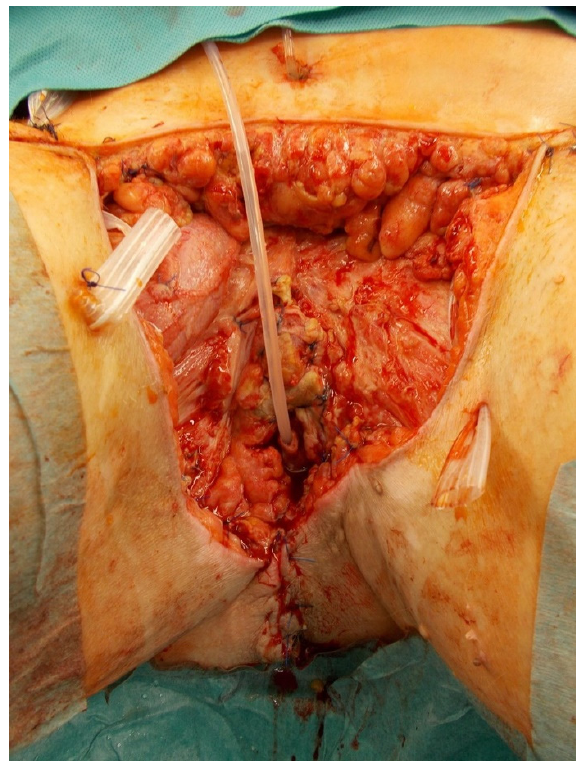
Figure 2. Extensive defect after radical debridement including penectomy for Fournier gangrene in a 68-year-old male patient. Urinary catheter is inserted into the remaining urethra.